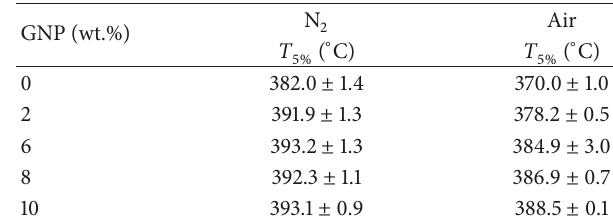
Table 3: Thermal degradation temperatures ( T 5 %) for PET-GNP nanocomposites under nitrogen and air